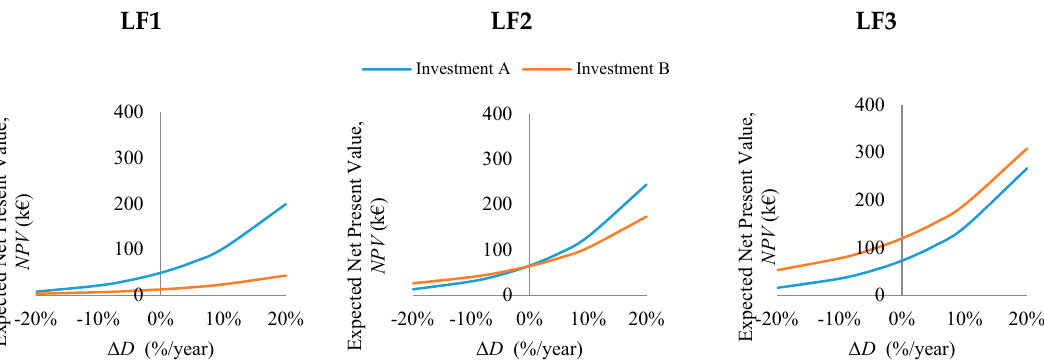
Figure 6. Effects on the NPV of both the investment options—"SEC reduction” (Investment A) and “SEC levelling” (Investment B)—while considering an annual variation of the demand rate.